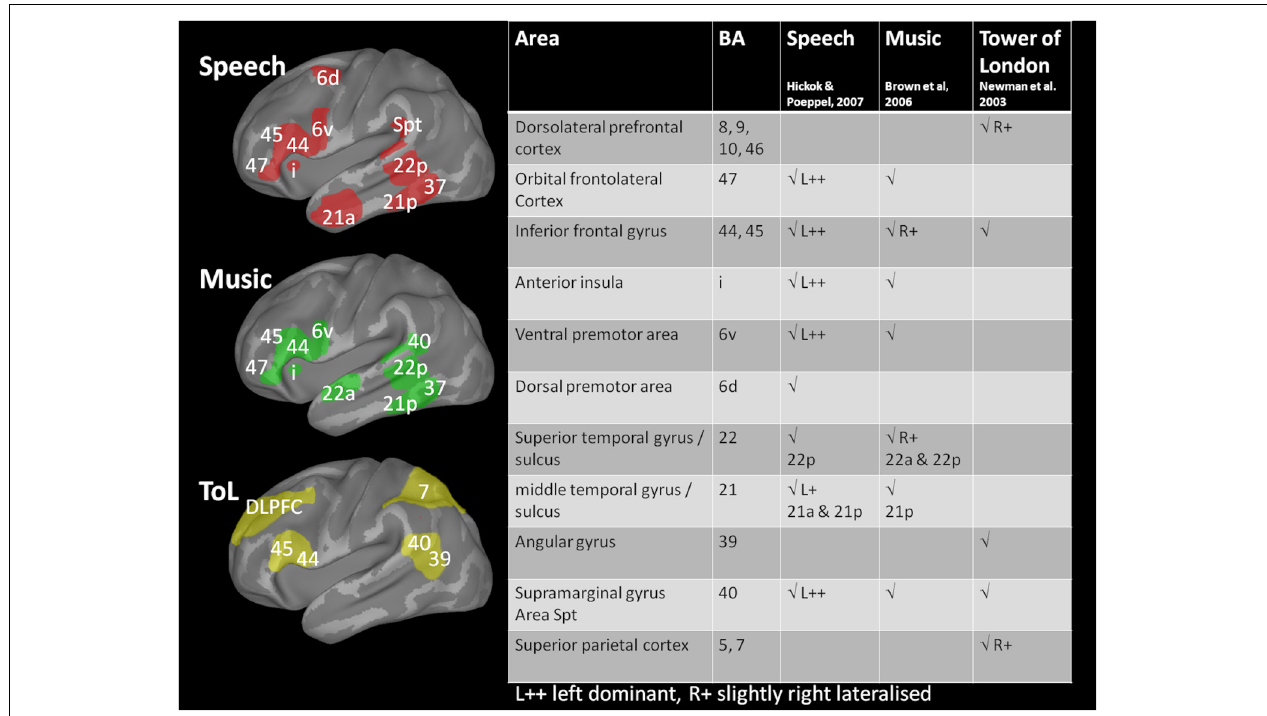
FIGURE 5 | Schematic diagram of brain activations associated with the three tasks. Brodmann areas activated by language tasks are shown in red (from Hickok and Poeppel, 2007); very similar areas, but less left lateralized are involved in music perception and generation tasks (green, from Brown et al., 2006). Solving the Tower of London problem (yellow, from Newman